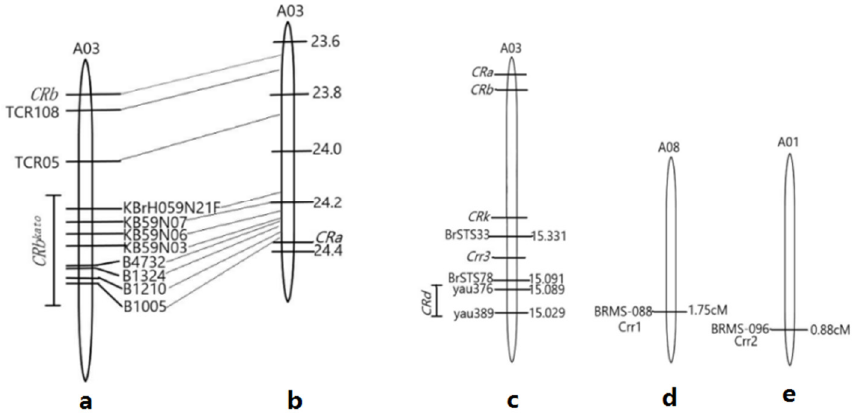
Figure 6. Identification of pathogen and disease test of the materials. Corresponding primers in ( a ) 1–6 represent PBRA_007750-2, Novel342-1, Novel407-2, PBRA_088439-1, PBRA_009348-1 and actin-1, ( b ) was the evolutionary tree of the CR genes, ( c ) was the in vitro identification results of “Yacui91”, ( d , e ) shows the in vitro identification results of hybrids from cabbage cross with turnip. European turnip and some oilseed rape varieties contained several important resis- tance genes that conferred vertical resistance to different physiological strains of P. brassicae